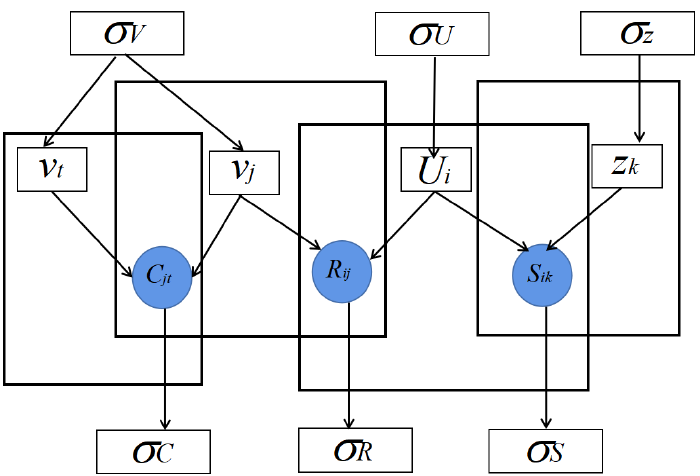
Figure 5. Diagram of the probability matrix decomposition model combining project association